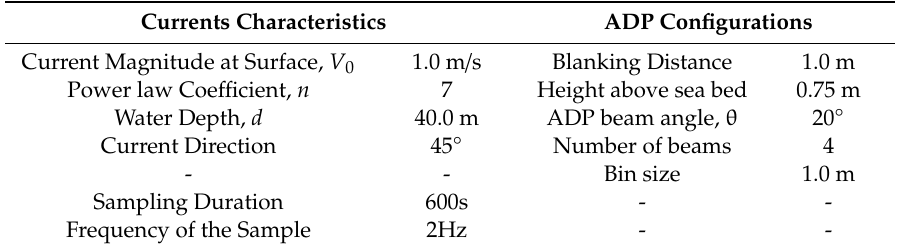
Table 1. Parameters for synthetic data generation and default acoustic Doppler profiler (ADP)